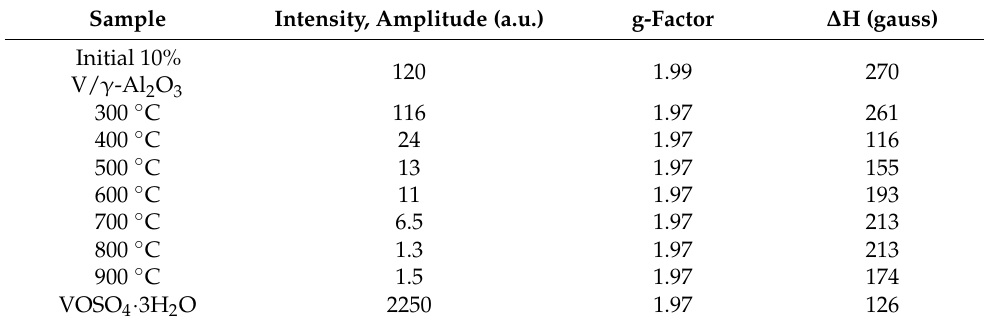
Table 2. Results of EPR spectra of vanadium-containing phases at various heating temperatures. Sample Intensity, Amplitude (a.u.)